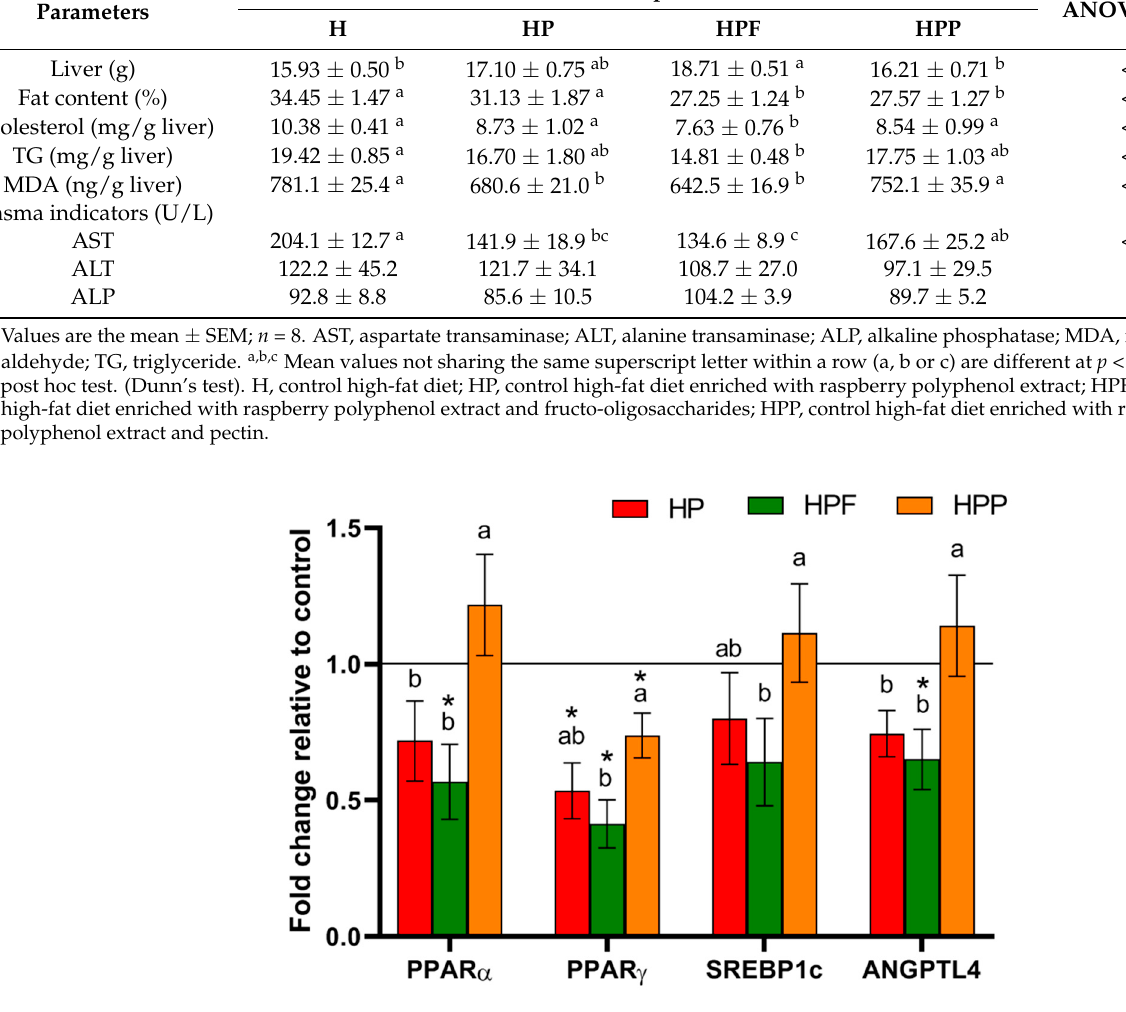
Table 4. Liver indicators of inflammation, oxidative stress and lipid metabolism in rats fed the experimental diets. Parameters